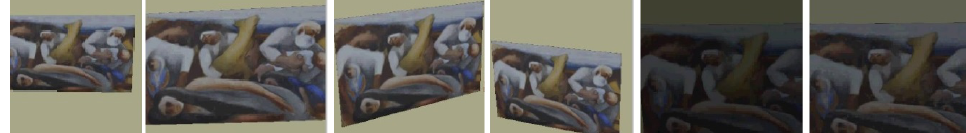
Figure 4. Typical examples of simulated training images for a particular